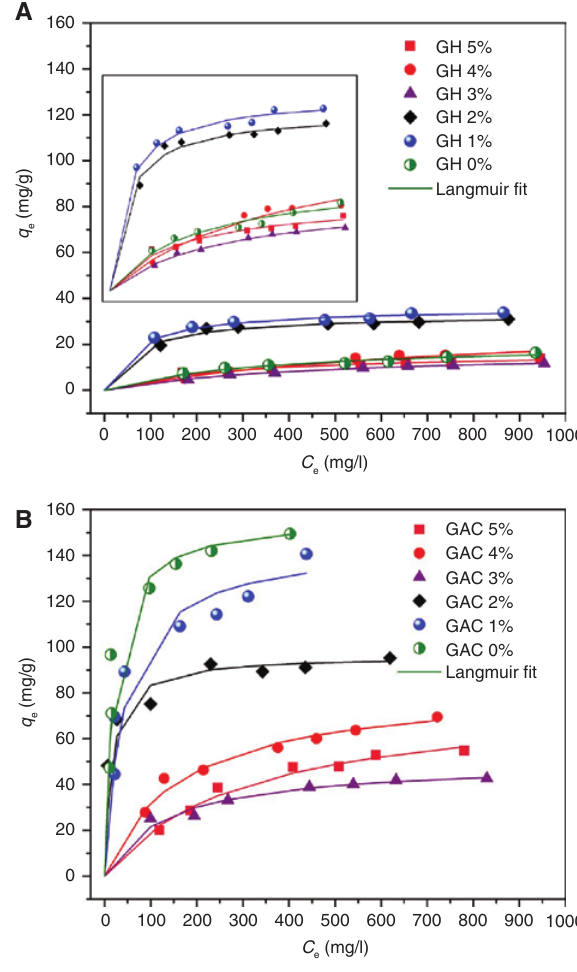
Figure 9: Adsorption isotherms of acid red 1 (AR1) by various (A) glucose hydrochar and (B) activated carbon (AC)